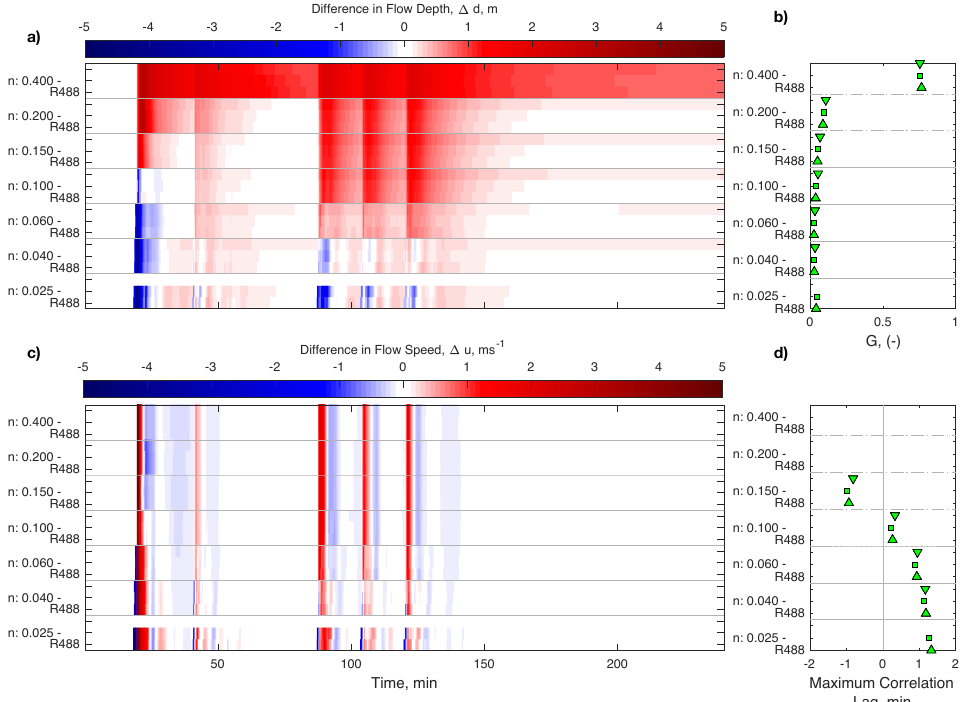
Figure 5. ( a ) Comparison of ∆ d i , k ( t ) (Equation (6)) for all n values and ratios, for inland gauge 3; ( b ) Value of the G parameter with (red) and without temporal offset (cyan); ( c ) Comparison of the velocity error for all n values and ratios; ( d ) Estimated time lag. In all panels, Manning n values increase vertically, and resolutions decrease vertically for each n value. In panels ( b – d ), symbols also denote the resolution: (cid:52) R 1 , (cid:3) R 2 , (cid:53) R 3